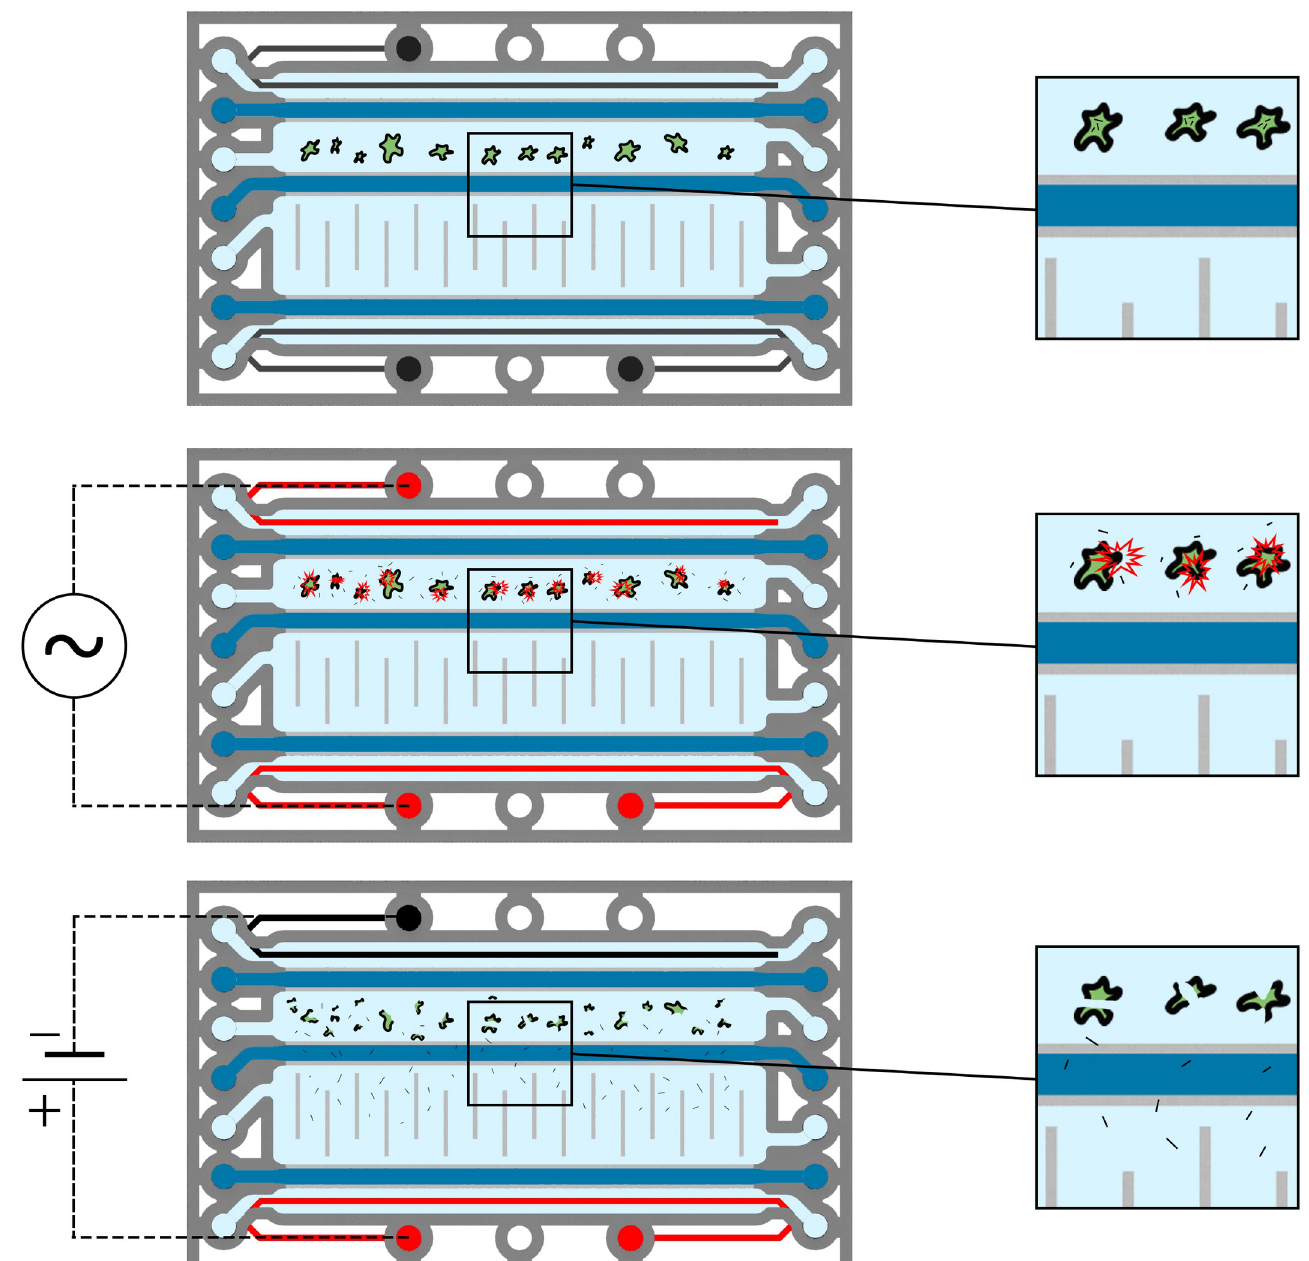
Fig 2. Illustration of the process for microfluidic miRNA extraction (top view). Top: Cells are introduced into the sample chamber. Center: A high frequency voltage is applied between the two coplanar electrodes (red)–cell lysis is caused by joule heating of the liquid sample. Bottom: A DC voltage is applied to the coplanar electrodes. Anionic miRNAs migrate through the separation hydrogel (dark blue) towards the anode (red) and are collected in the elution chamber. Large nucleic acids and non-polar cell debris remain inside the sample